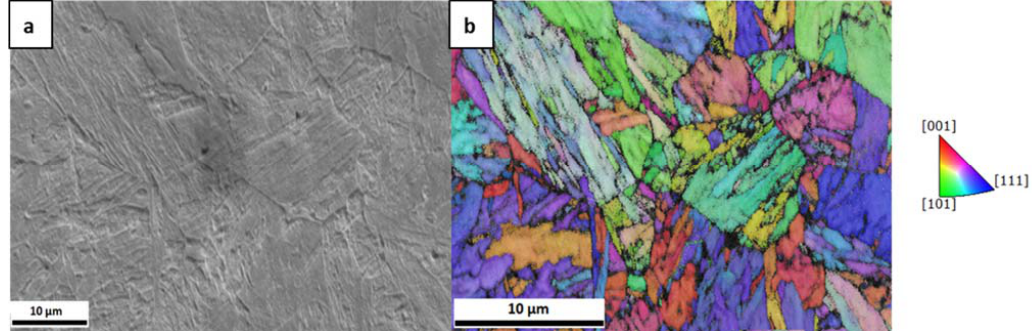
Figure 1. ( a ) Secondary electron image; and ( b ) inverse pole figure in the normal direction of the investigated CP1200 microstructure.